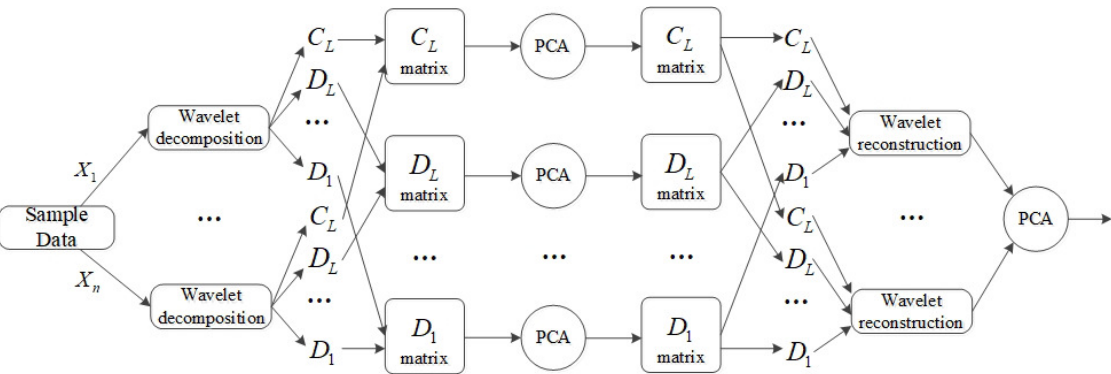
Figure 4. The flow chart of the calculation of MSPCA (multiscale principal component analysis)